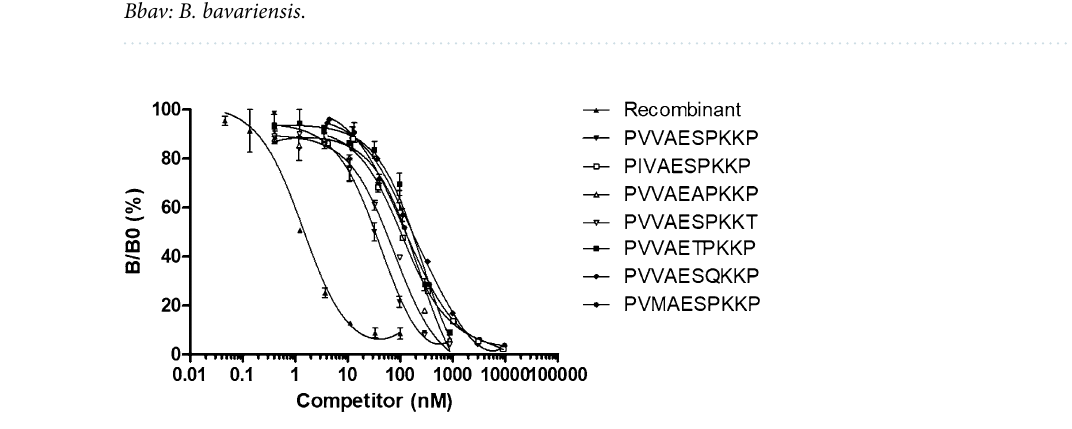
Figure 2. Competition ELISA experiments with various C10 peptide variants. B/B0 represents the percentage of binding of the C10-11 mAb with the C10 peptide tracer. The results are expressed in terms of B/B0 as a function of the logarithm of the competing C10 variant or OspC. Data shown are representative of three independent experiments. Data from non-competing peptides (peptides 4; 6; 8 and 11 in Table 2) are not included in the